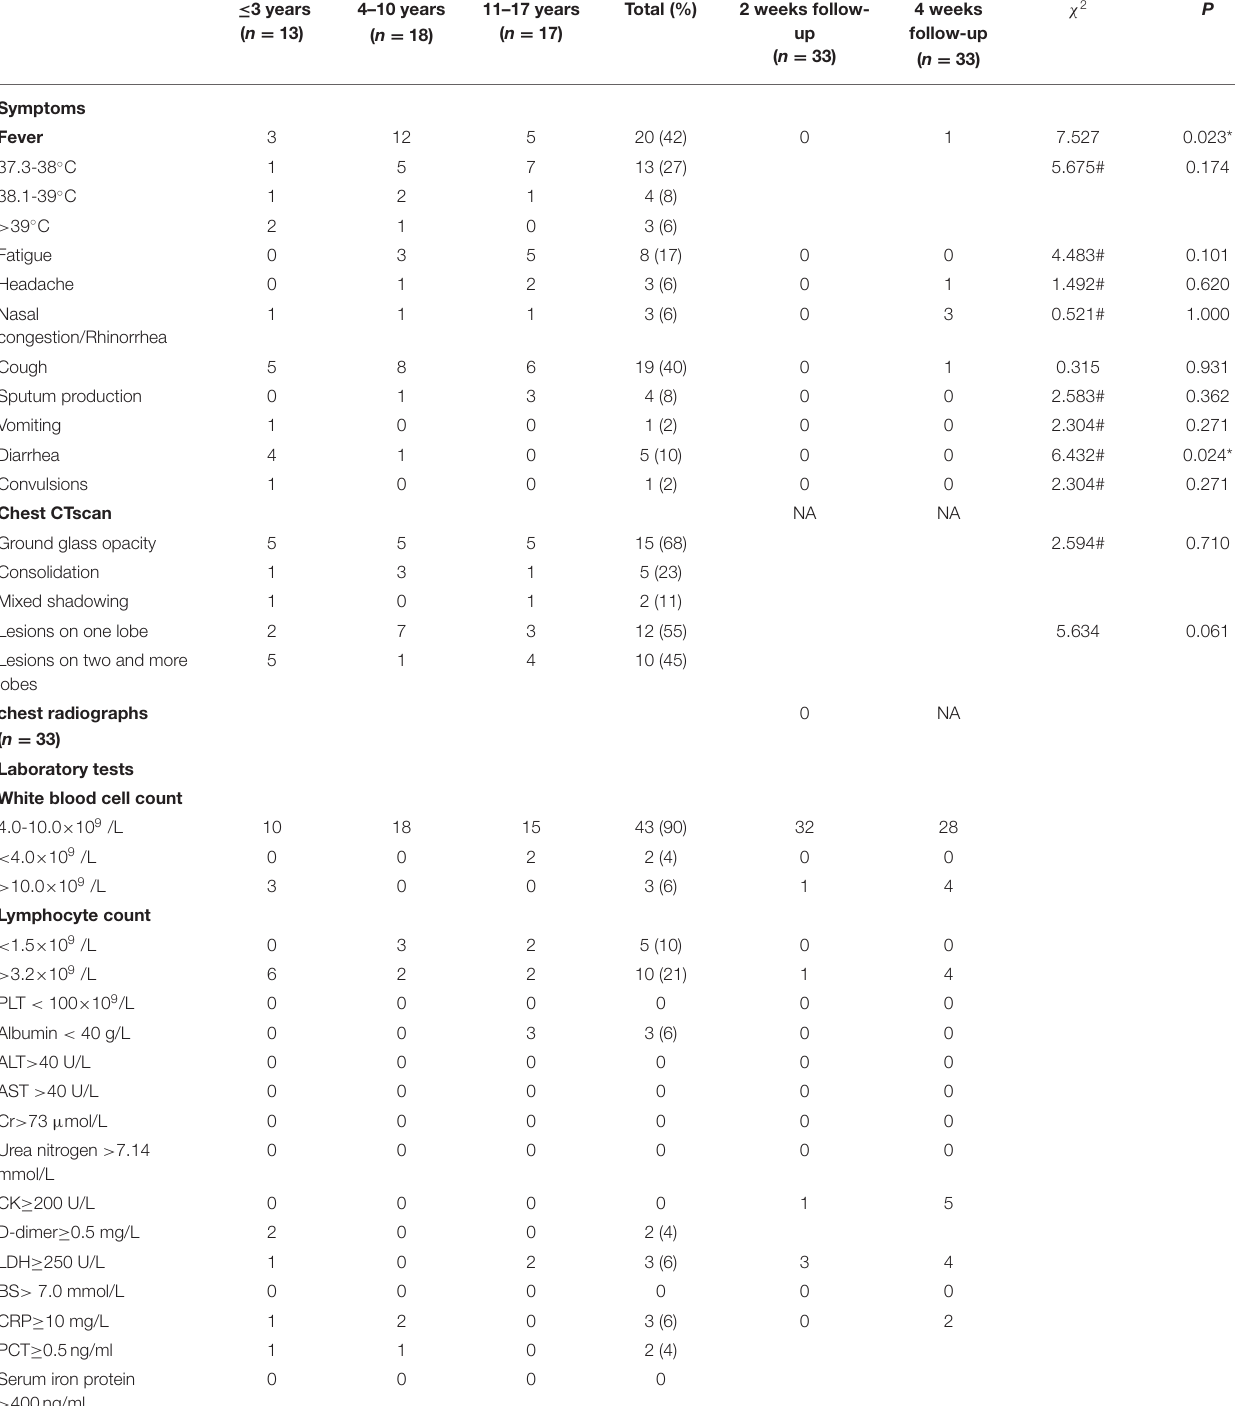
TABLE 2 | Clinical features and radiographic findings of 48 children with COVID-19 and follow-up examination of 33 pediatric patients after 2 weeks and 4 weeks